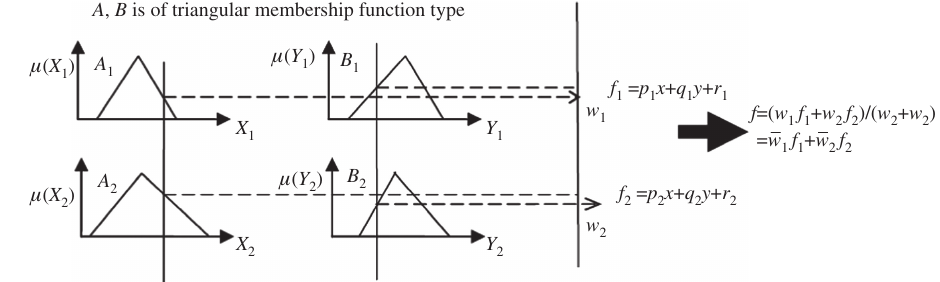
Figure 10 The reasoning scheme of ANFIS [44].